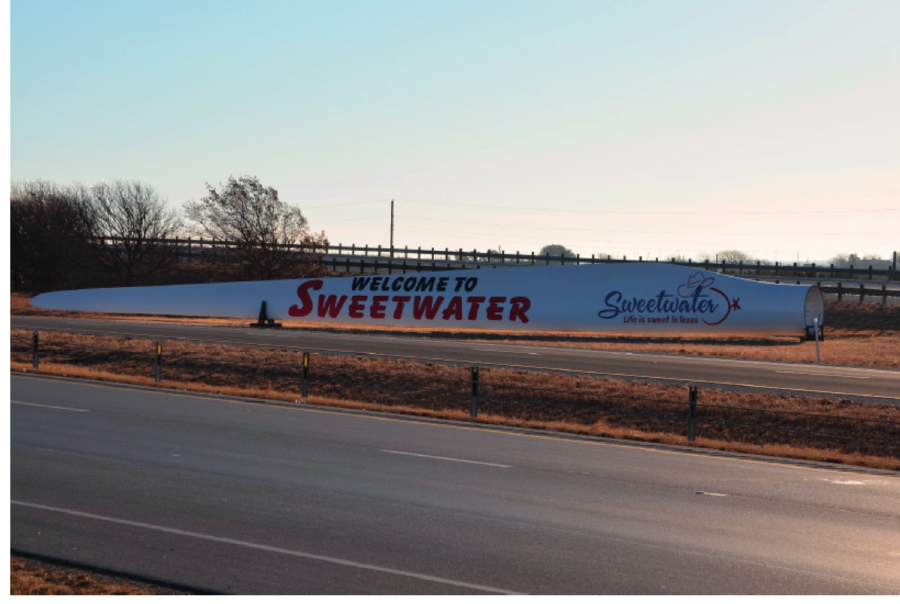
Figure 2. Wind turbine blade on Interstate 20 in Sweetwater suggesting the importance of wind energy to the city’s identity and